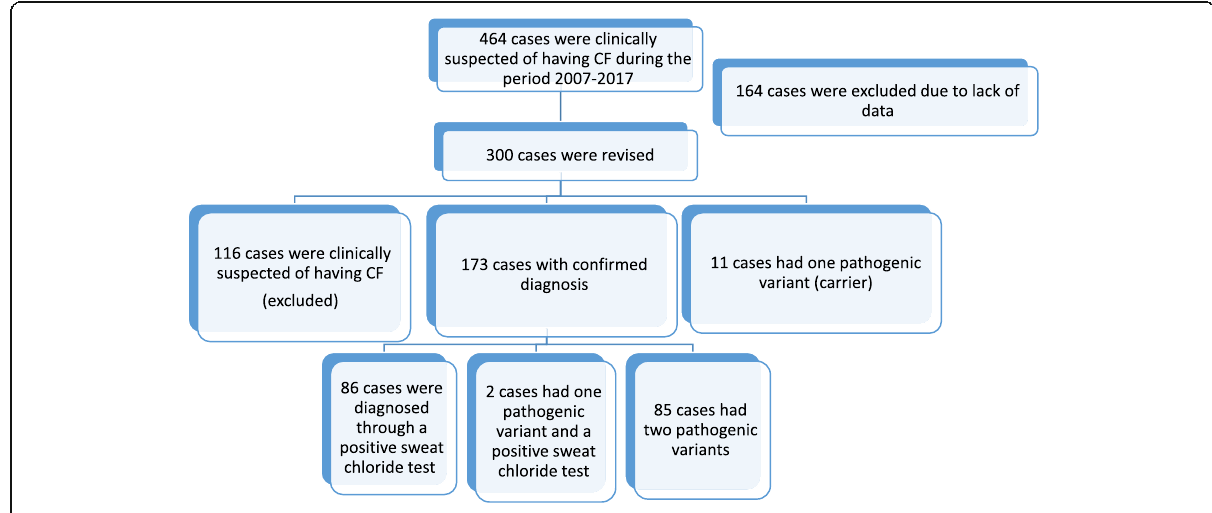
Fig. 1 Flow chart of study identification and inclusion and exclusion criteria